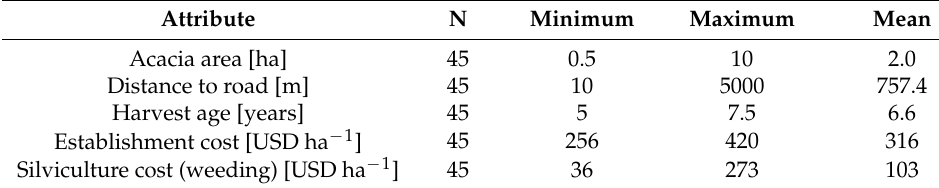
Table 1. Descriptive statistics of